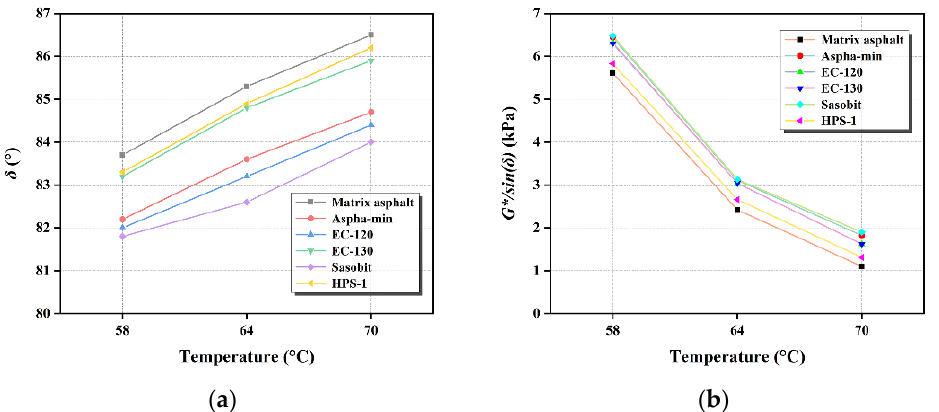
Figure 2. Test results of dynamic shear properties of asphalt after short-term aging under different temperatures: ( a ) Phase angle; ( b ) G* /sin δ .